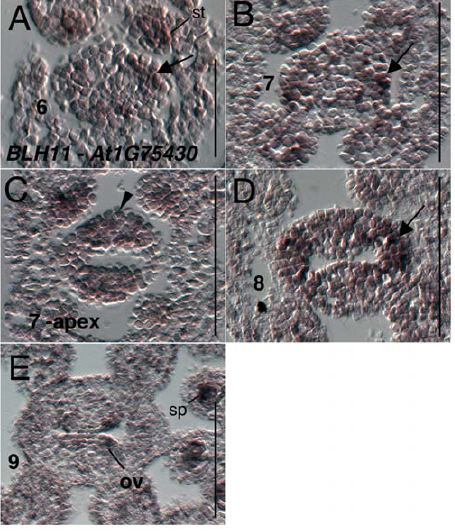
Figure 12. Results of insitu hybridization with YAB3(At4g00180) antisense probe. Numbers indicate floral stages. All panels show transverse (cross sectional) tissue orientation. Scale bar in D represents 100 microns for all panels. Arrows indicate abaxial valve domain expression. All panels are Col-0 wild type tissue unless otherwise marked.